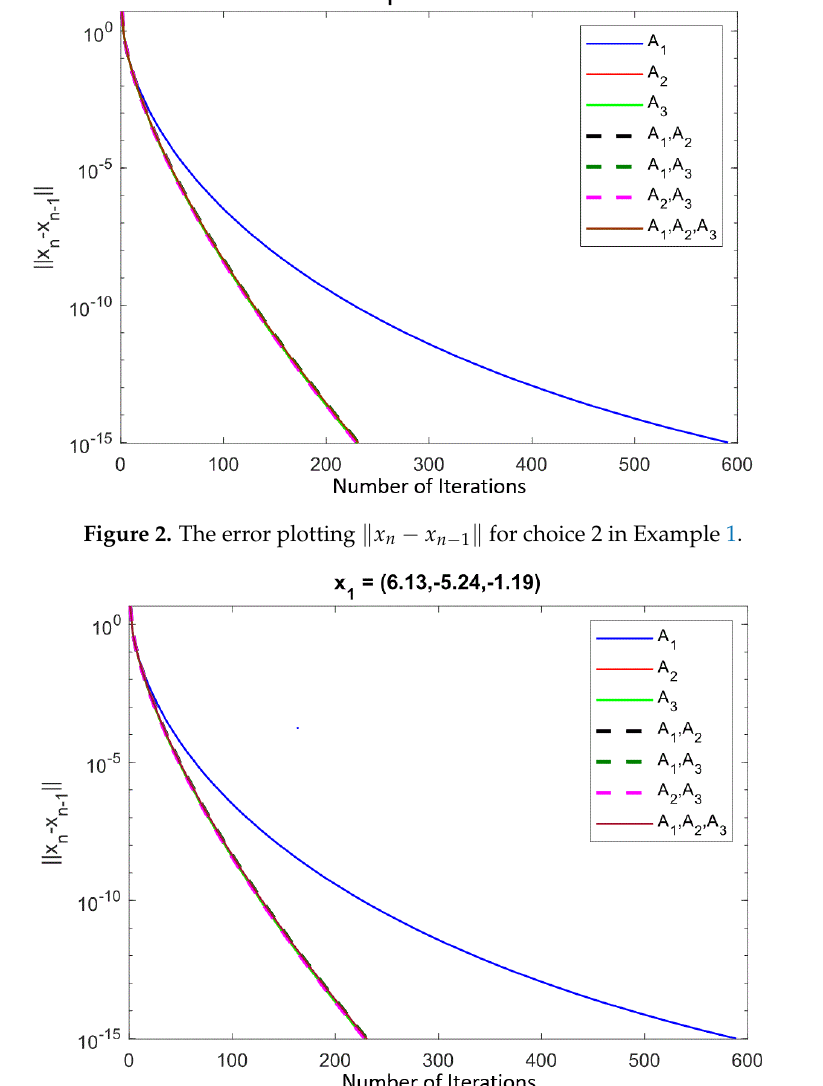
Figure 3. The error plotting (cid:107) x n − x n − 1 (cid:107) for choice 3 in Example